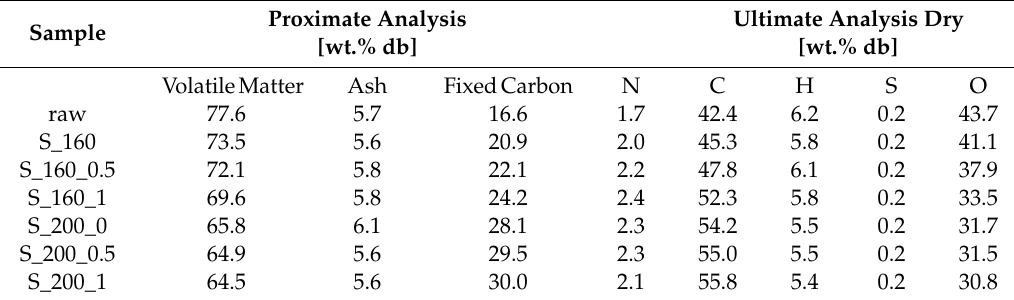
Table 2. Proximate and ultimate analysis of original biomass and